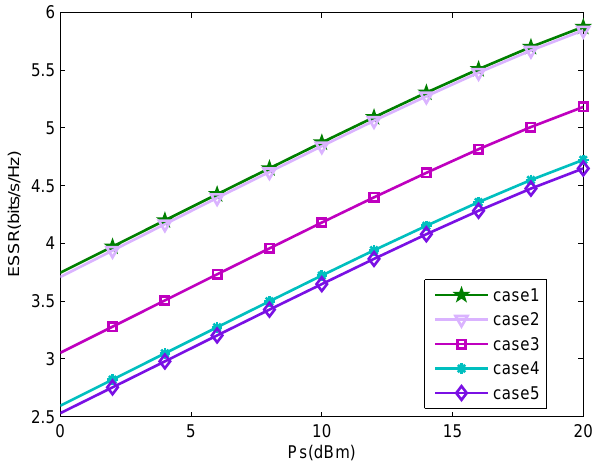
Figure 4. ESSR versus the whole transmit power P s with different channel gains.